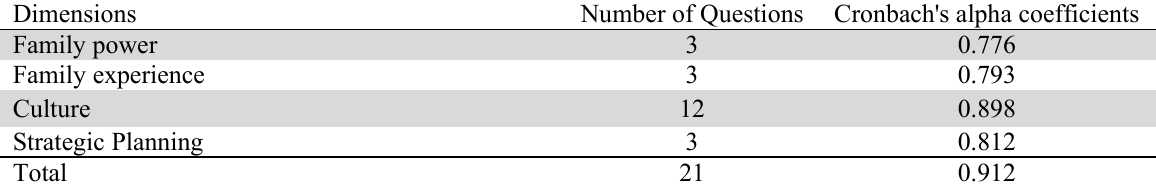
The reliability calculation of research